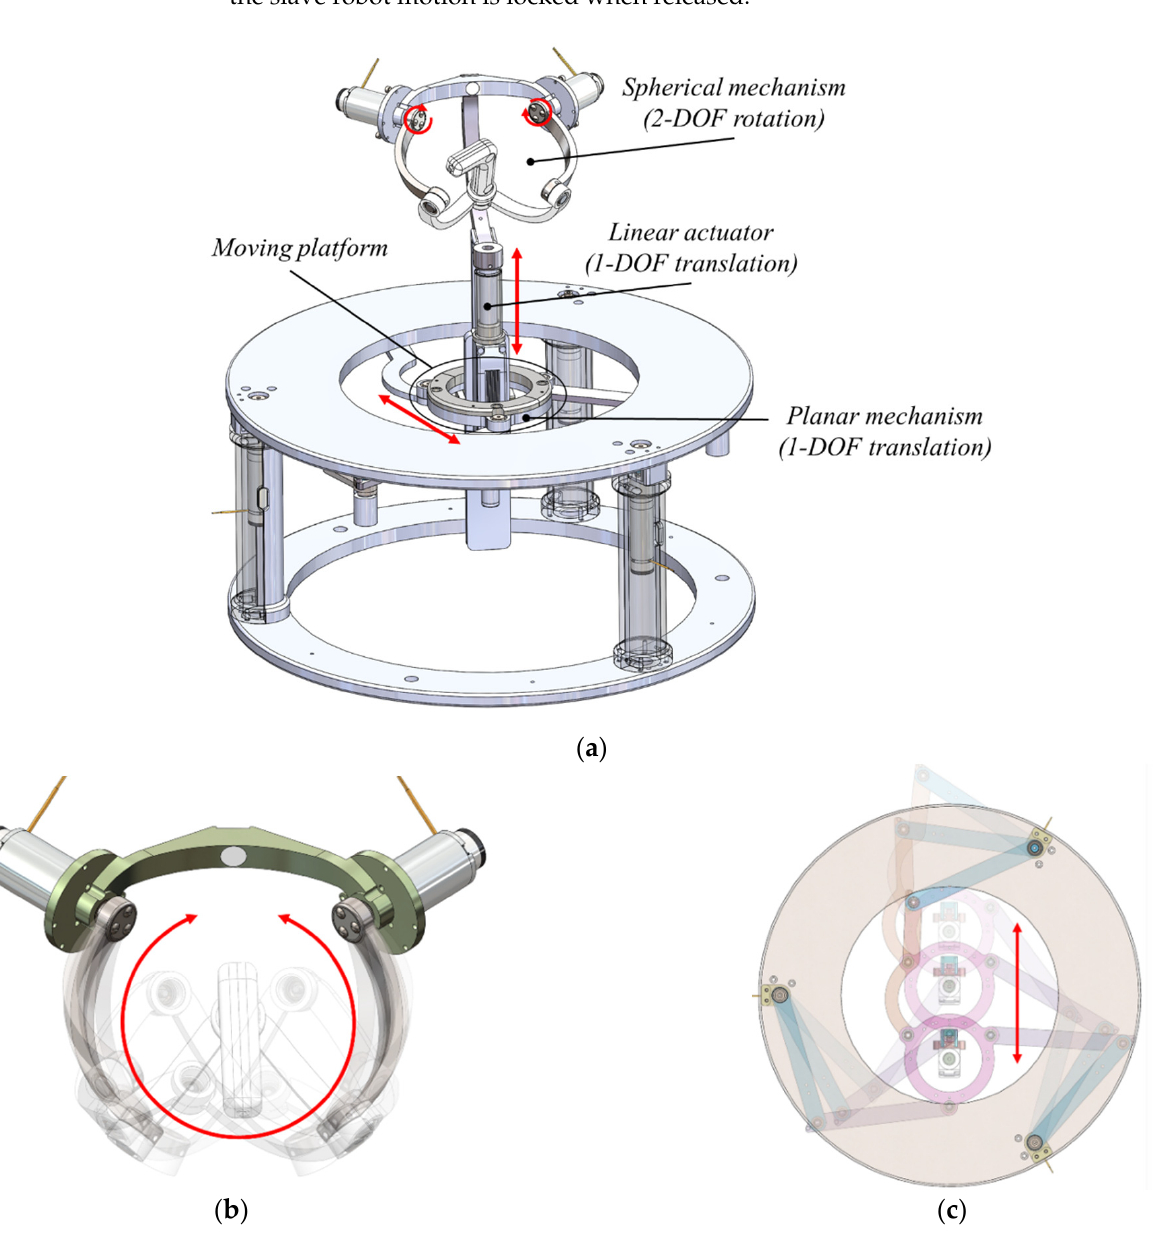
Figure 4. Design of ( a ) the master haptic device and master haptic device matching concept, ( b ) rotational motion, ( c ) translation motion.